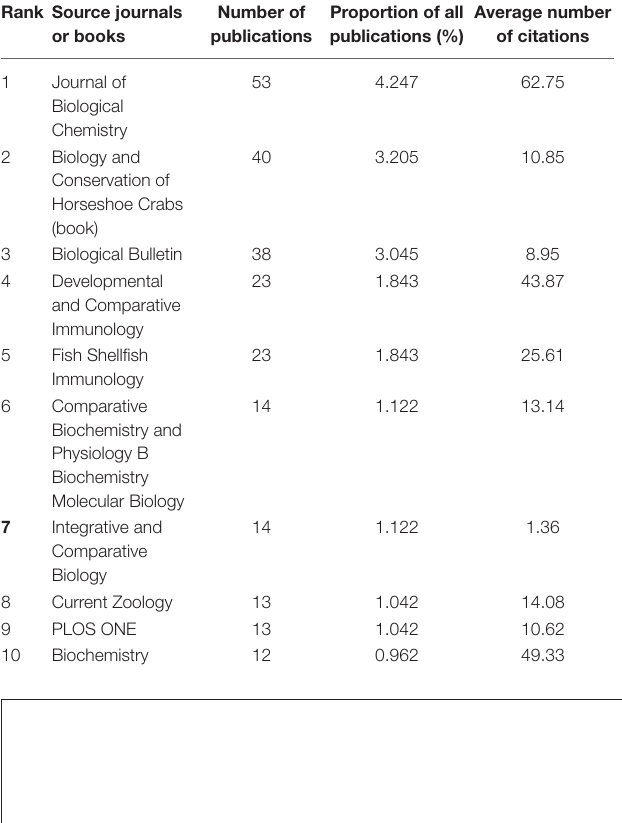
The phrase “horseshoe crab” had the highest frequency because it was the name of the study object ( Figure 5 ). In 2000, TABLE 5 | Numbers of publications, the proportion of all publications, and the total number of times the top 10 source journals are cited and ranked by the number of publications based on WOS.